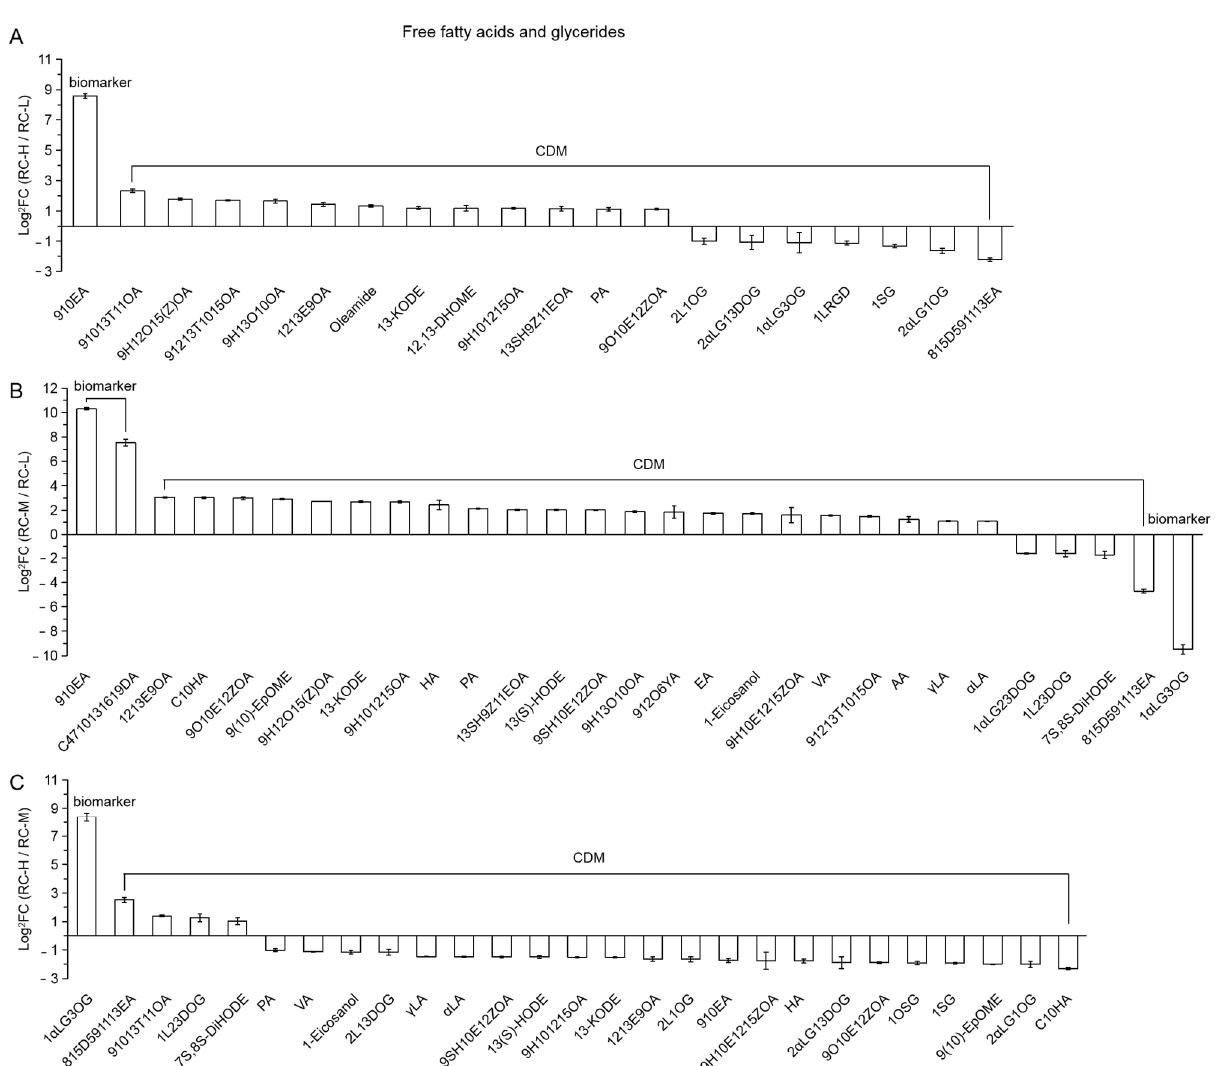
Figure 17. Comparison of differential metabolites of Free fatty acids and glycerides between RC-L, RC-M and RC-H. These were 1 biomarker and 19 CDMs for RC-H vs. RC-L ( A ), 3 biomarkers and 26 CDMs for RC-M vs. RC-L ( B ), and 1 biomarker and 26 CDMs for RC-H vs. RC-M ( C ). Upregulation denotes that the content of a metabolite in RC increased with elevation between two altitudes, and the opposite for downregulation. The Y-axis is shown as Log 2 FC values for the convenience of visual presentation (Note: The up-amplitude in the text refers to the FC value). The X-axis denotes metabolite names.